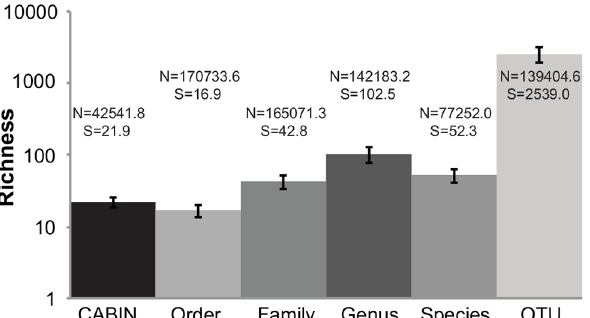
Fig 1. Raw biodiversity data for 24 benthic samples from the Peace-Athabasca delta at six different taxonomic levels via morphological identification and HTS. Mean taxon richness (S) of all samples plus one standard deviation is depicted. N denotes the mean number of sequences identified at this taxonomic level per